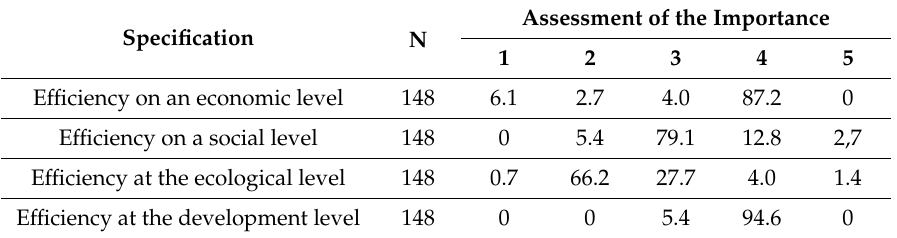
Table 3. Subjective evaluation of e ff ectiveness at di ff erent levels according to the respondents